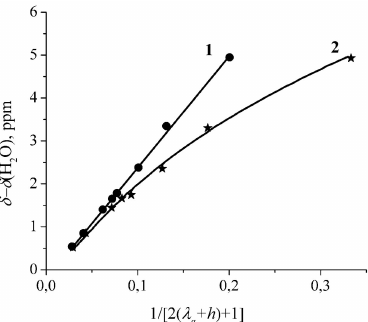
Figure 7. Dependences on humidity of 1 H chemical shift (relative to the bulk water signal) in Nafion 117 membranes. λ g is the gravimetrically measured amount of water molecules per sulfonate group after membrane drying to constant weight at 110 ◦ C or equilibrated with dry P 2 O 5 , h is hydration number of H + (H 2 O) h ); 1— h = 2 (H 5 O 2+ ) line is Equation 1.2 at δ H2O = 4.3 ppm and δ c = 13.8 ppm, circles—experiment; 2— h = 1 (H 3 O + ) is experimental curve given for comparison. Reprinted with permission from [25]. Copyright 2019 Springer Nature.